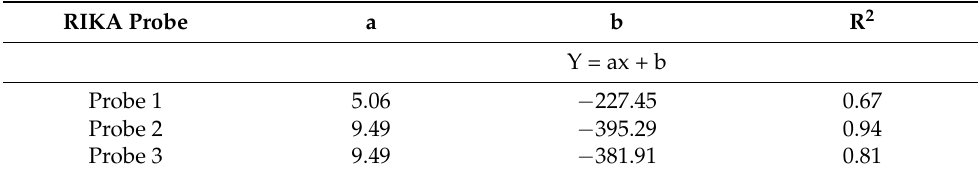
Table 6. Fitting and determination coefficient for the RIKA probes when increasing the nitrate concentration in sand at 35% volumetric soil moisture.